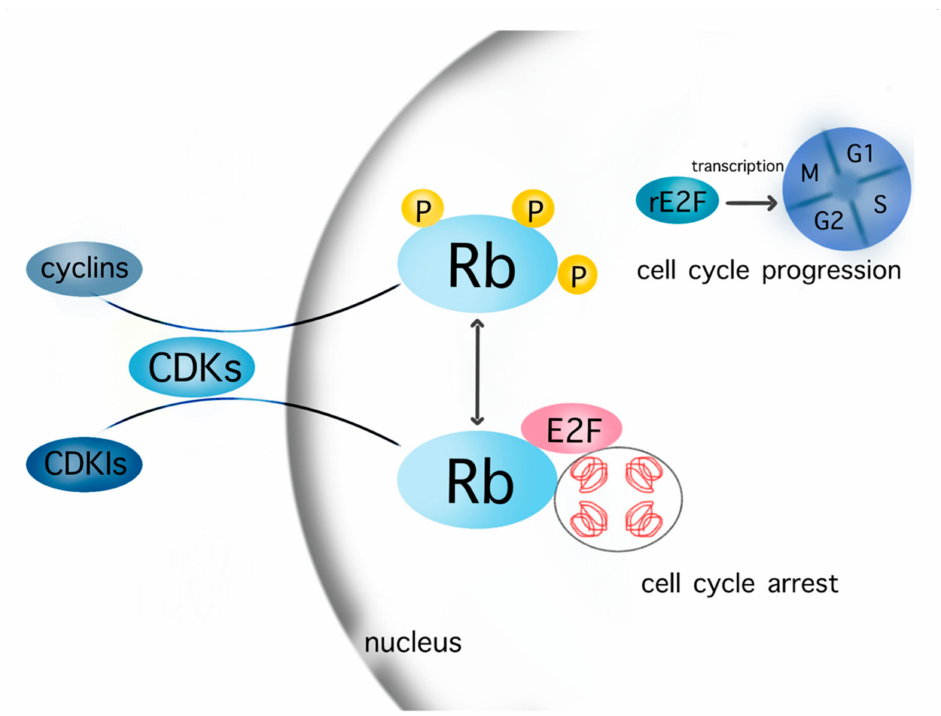
Figure 1. Cell cycle cascades. The cells enter the cell cycle after transcription of released E2F in the nucleus, which is promoted by the phosphorylation of Rb in the context of the interaction between various cyclins–CDKs complexes and Rb. The contrary complex CDKIs–CDKs inhibits the phosphorylation of Rb. Consequently, Rb and E2F are not released from chromatin but still bind to a firm complex, which leads to cell cycle arrest. Abbreviations: CDKs: cyclin-dependent kinases; CDKIs: cyclin-dependent kinases inhibitor; Rb: retinoblastoma, rE2F: released E2F. Most known cyclins: cyclin A, B1, B2, D1, D2, D3, E1, E2, G1; CDKs: CDK1, 2, 4, 6, 9; CDKIs: p16, p21, p27,